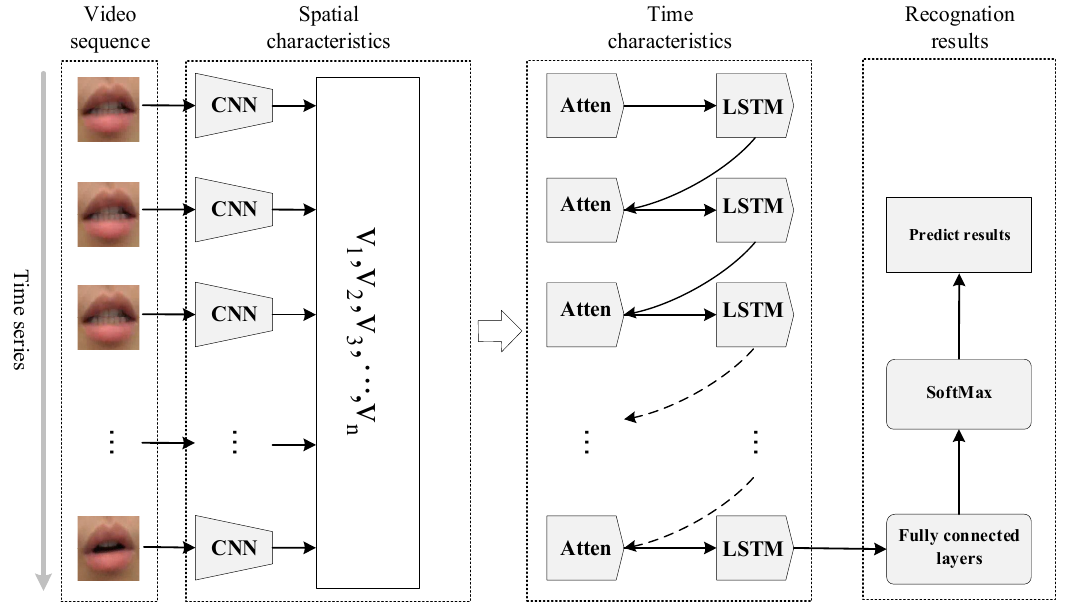
Figure 1. The architecture of our proposed convolutional neural network (CNN) with attention-based long short-term memory (LSTM).